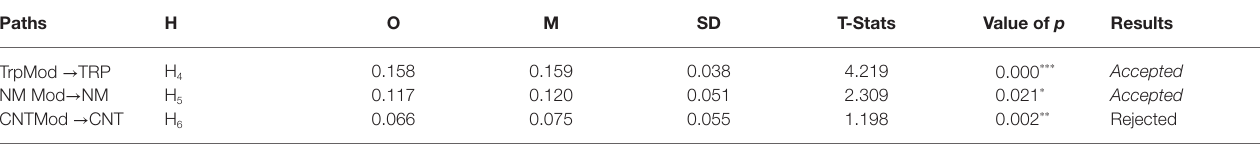
TABLE 6 | Moderation effect.